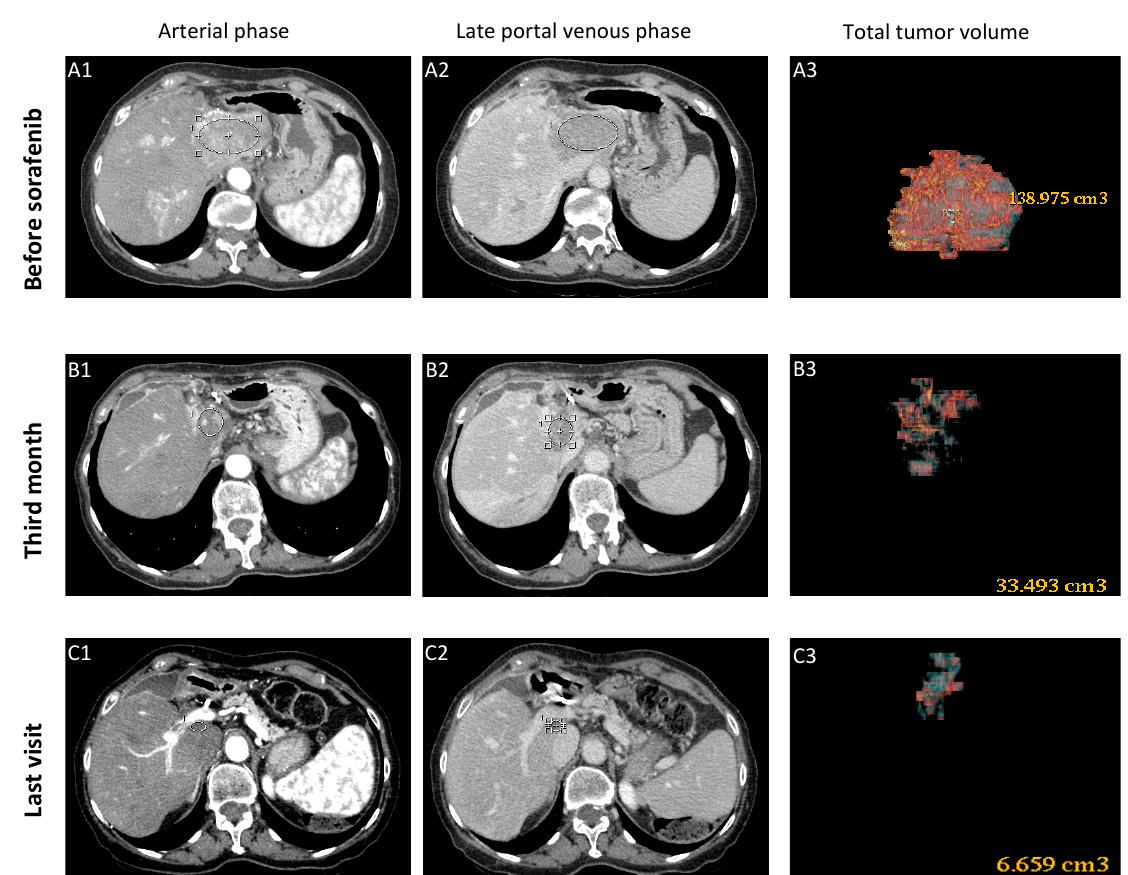
Figure 1. Baseline CT scan ( A1 , A2 ) showing the large HCC mass (maximum diameter 75 mm) in the left liver lobe with contrast enhancement in the arterial phase and wash-out in the late portal phase with vascular invasion. Follow-up CT scans demonstrated the markedly reduced sized necrotic lesion (maximum diameter 32 mm) at the third month of therapy ( B1 , B2 ) that remains barely noticeable (maximum diameter 18 mm) at the last visit ( C1 , C2 ), with no contrast enhancement in both phases. Total tumor volume (TTV) declined from 138.9 cm 3 ( A3 ) to 33.4 cm 3 ( B3 ) in 3 months, and to 6.6 cm 3 at the last visit ( C3 ) after 48 months from the beginning of therapy.